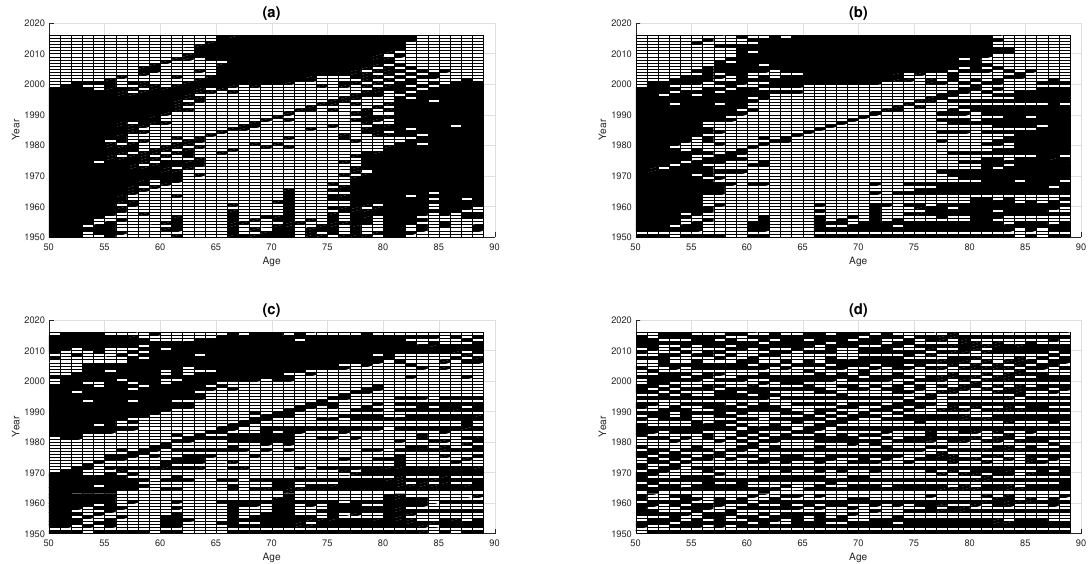
Figure 1. Residual plots for the ( a ) CBD MLE model, ( b ) CBD LLE model, ( c ) 2D LOP model and ( d ) 2D KS model based on GB male mortality data from 1950–2016, ages 50–89.